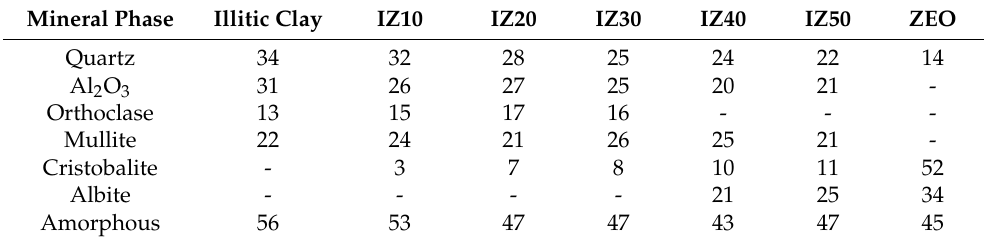
Figure 6. XRD analysis of the prepared samples. Table 3. Phase composition of the fired samples (in